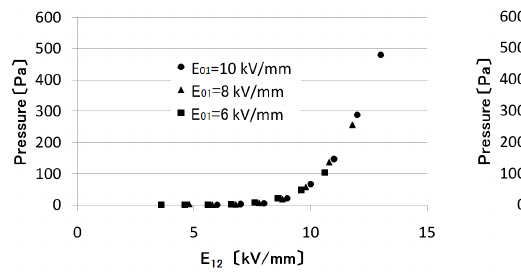
Fig. 15 Mean static pressure as a function of the electric fields |E | (=| V /H|) and E (= V /D) 02 2 01 1